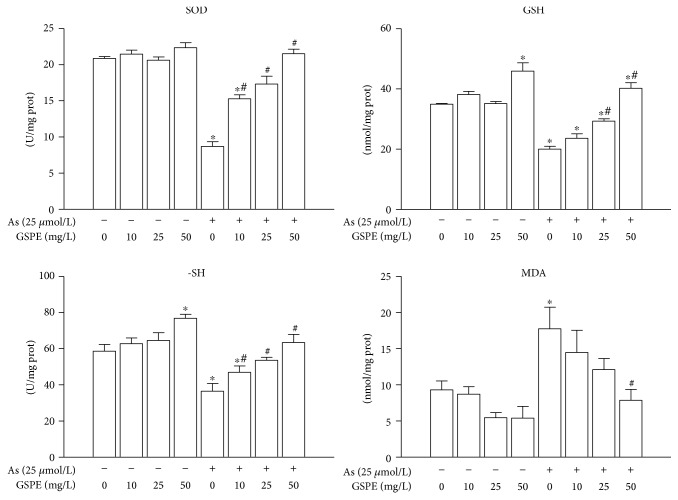
Oxidative stress changes in L-02 cells after arsenic and/or grape seed procyanidin extract treatment for 24 h (mean ± SD, n = 3). ∗Versus the control group, P < 0.05; #versus the arsenic group, P < 0.05. Treatment with arsenic caused a prominent decrease in GSH, SOD, and -SH levels compared with the control group. MDA content was significantly higher in the arsenic group than in the control group. Treatment with arsenic + GSPE elevated GSH, -SH, and SOD levels compared with the arsenic group.